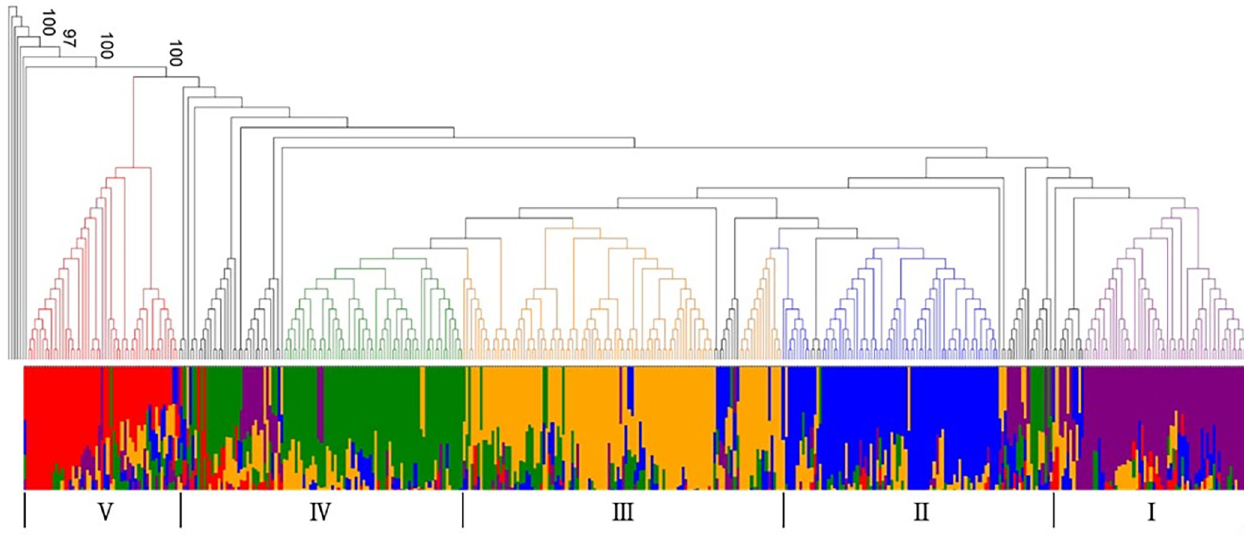
Fig 4. Phylogenetic tree of the core collection. The core collection was divided into five subpopulation clades (I-V).